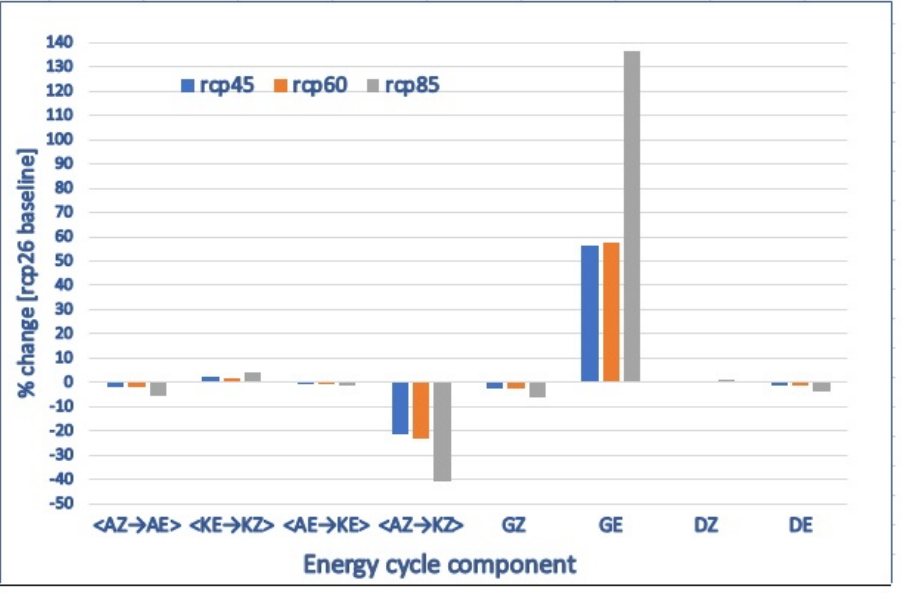
Figure 7. Percent change of Lorenz energy cycle components, considering the rcp26 as a